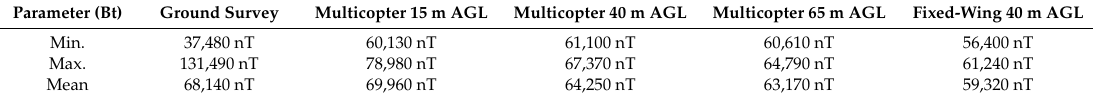
Figure 11. TMI plots from all magnetic surveys with flight heights given in AGL, blue line defines the outcrop border. ( a ) Ground survey–dashed square outlines the reference area for Table 6. ( b ) Multicopter survey at 15 m flight height, consisting of two stitched flights, seen in inset map. ( c ) Multicopter survey at 40 m AGL. ( d ) Multicopter survey at 65 m AGL. ( e ) Fixed-wing survey at 40 m AGL. Statistical details for the magnetic field from the di ff erent surveys at the Metsämalmi outcrop area are given for a defined reference area in Table 6 (see this area outlined with a rectangle in Figure 11a). Table 6. Comparison of TMI grid values from the same area, shown in Figure